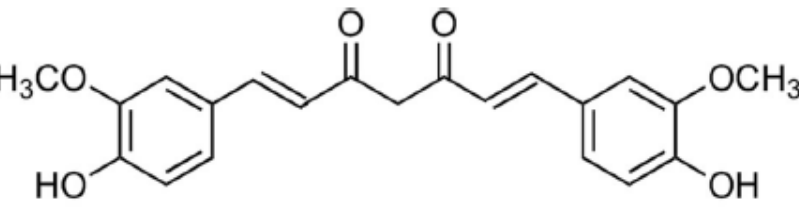
Figure 1. Molecular structure of curcumin (CCM).